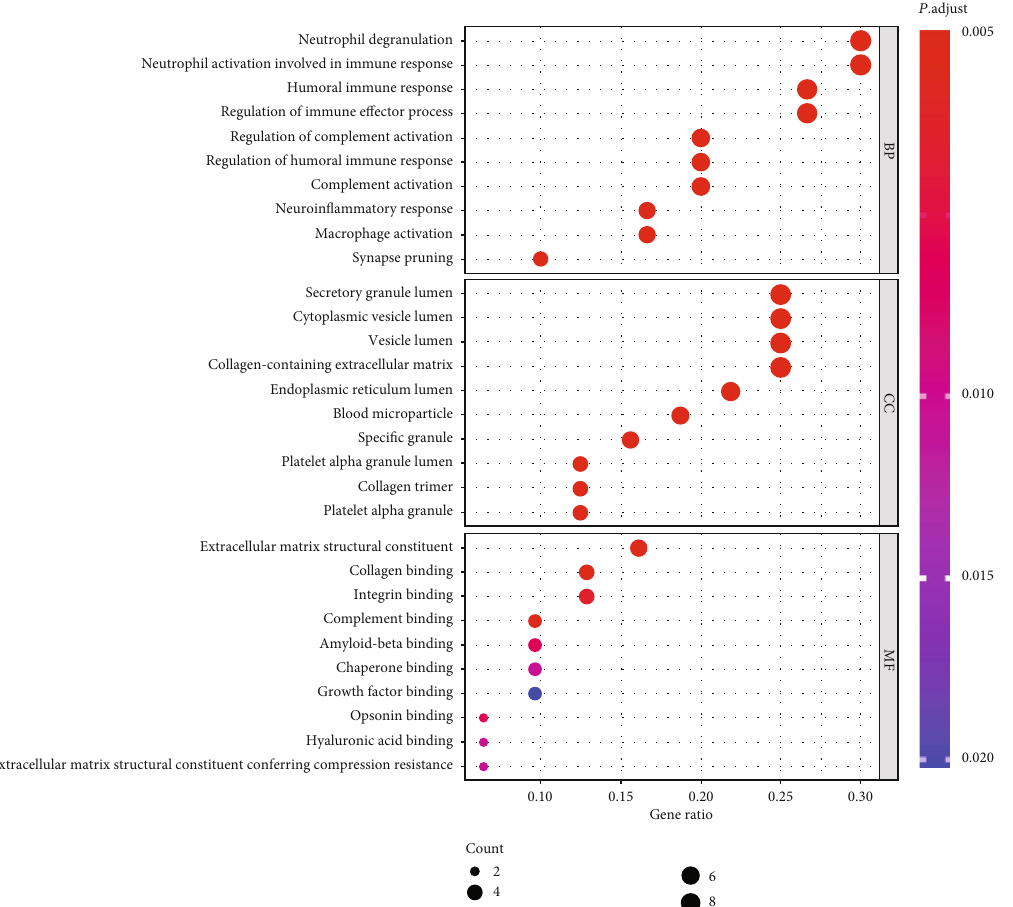
Figure 7: Enriched GO terms for BP, MF, and CC of hub genes. The color of the node is displayed in a gradient from red to blue according to the ascending order of the P value, while the size of the node is showed according to the ascending order of the number of gene